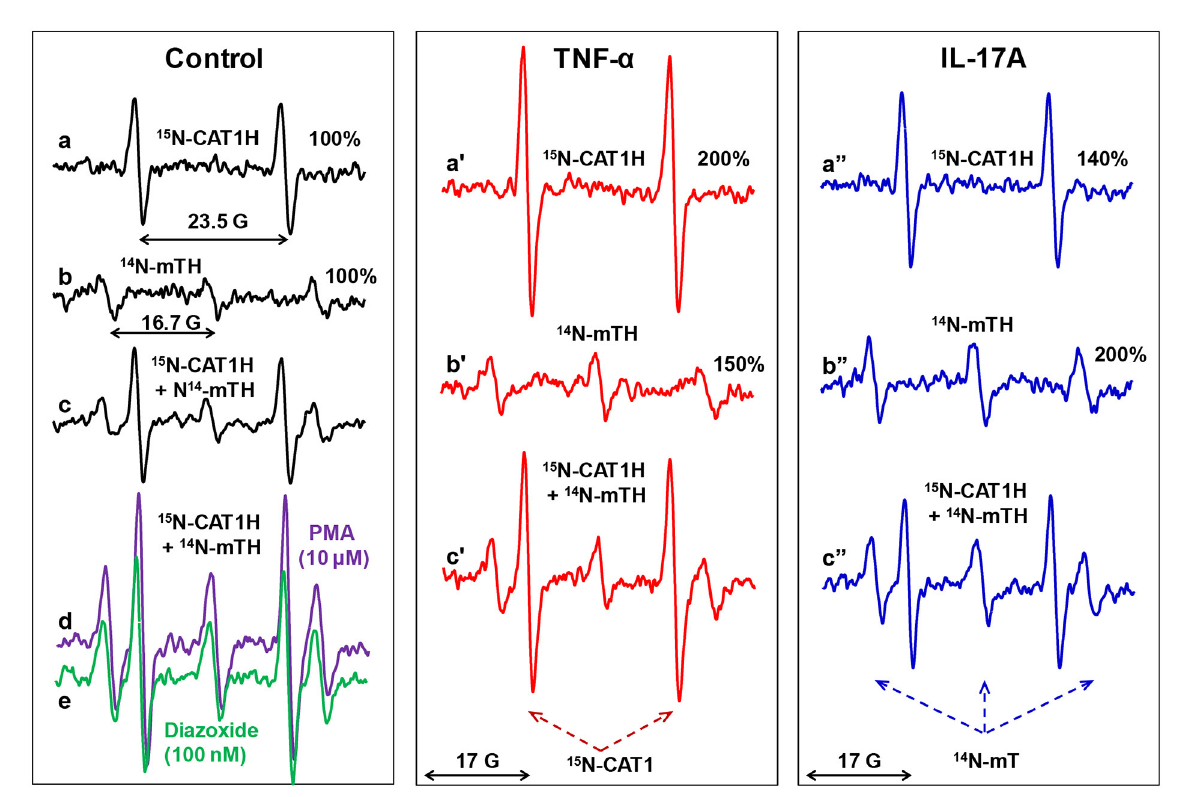
FIGURE3 Simultaneous EPR detection of extracellular and mitochondrial O 2 • by 15 N-CAT1H and 14 N-mitoTEMPO-H ( 14 N-mTH) spin probes in splenocytes. Mouse splenocytes were stimulated ex vivo with TNF α (1ng/ml) or IL-17A (10ng/ml) for 3-h. Cells (10 7 /ml) were supplemented with 14 N-CAT1H (0.5mM) and/or 14 N-mitoTEMPO-H (25 µ M) and incubated for 30min at 37 ◦ C prior to EPR analysis. Unstimulated splenocytes were treated acutely with NADPH oxidase activator PMA (10 µ M) or inducer of mitochondrial superoxide diazoxide (0.1 µ M) as a “positive control” for increased superoxide production. Figure shows typical ESR spectra of four independent